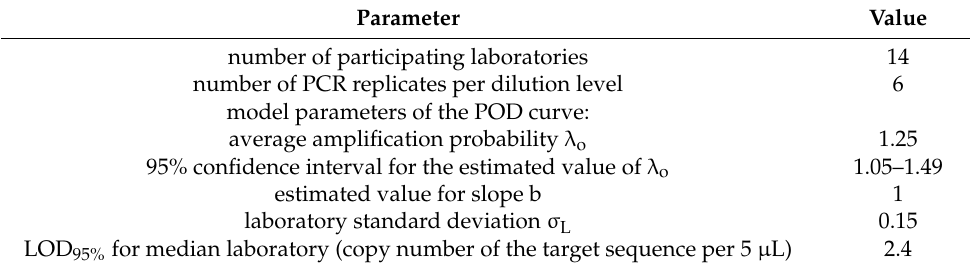
Table 6. Summary of the POD statistics for the real-time PCR assay for roe deer.